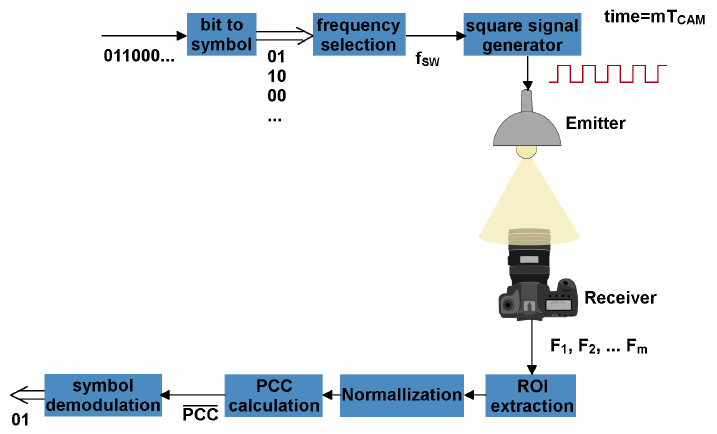
Figure 2. Transmission diagram.